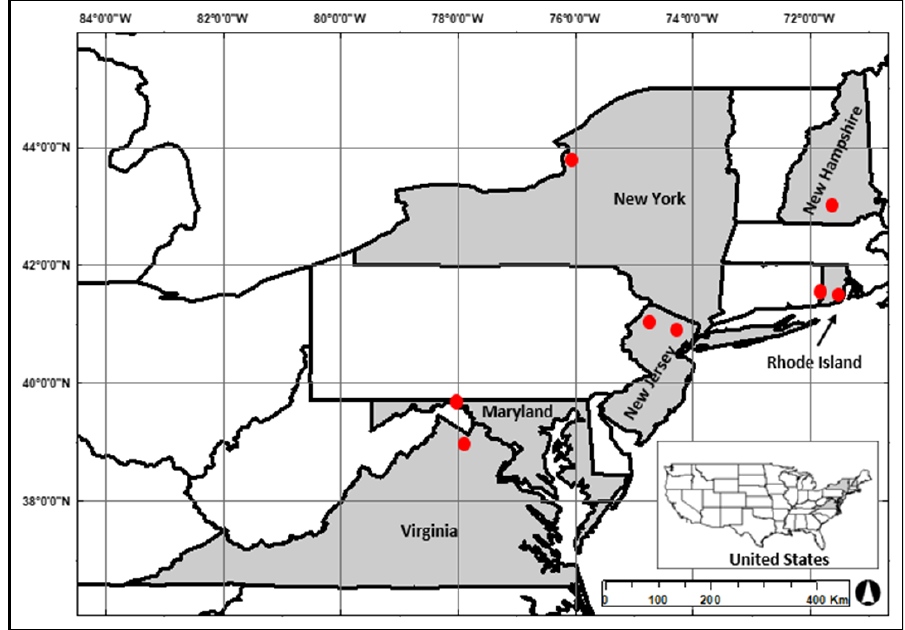
Figure 1. Little brown bat ( Myotis lucifugus ) capture locations, represented by red points, in the Northeast and Mid-Atlantic USA, 2022.